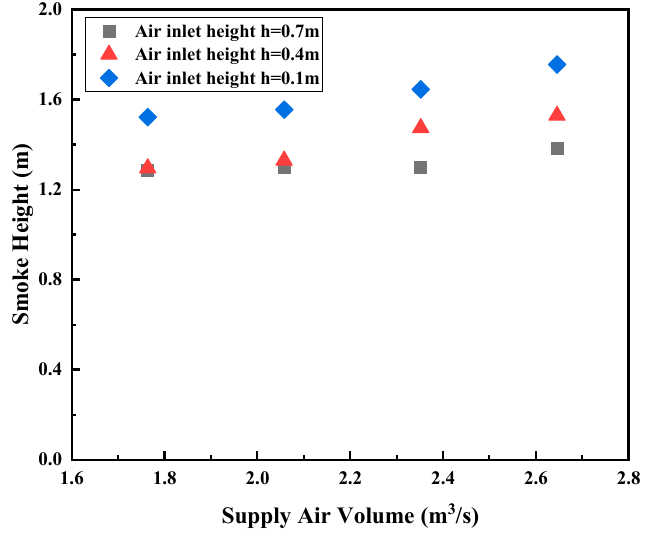
Figure 10. Comparison of cabin smoke layer heights under different supply air volume conditions. Based on the above data, let the dimensionless smoke layer height H ∗ = H / H 0 , the dimensionless air inlet height h ∗ = h / H 0 , and introduce the dimensionless parameters P and Q to make the data dimensionless. The curves of P and Q after processing are shown in Figure 11. It can be seen that P and Q are approximately linearly related: P = 1.72 × Q + 50.79.